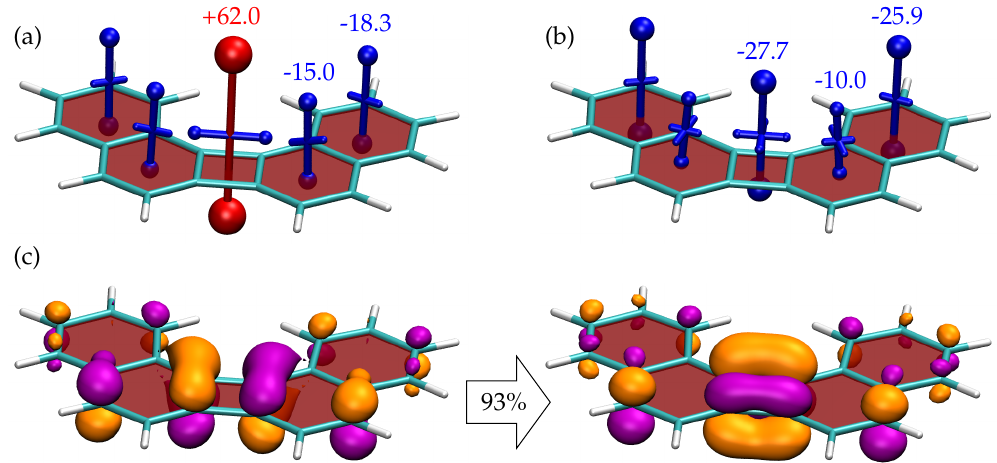
Figure 8. Visualisation of chemical shielding tensors (VIST) for ( a ) the S 0 and ( b ) the T 1 states of 5 computed 1 Å above the molecular plane. The dominant pair of natural transition orbitals (isovalue 0.05 a.u., weight 93 %) for the S 0 → T 1 transition is shown in ( c